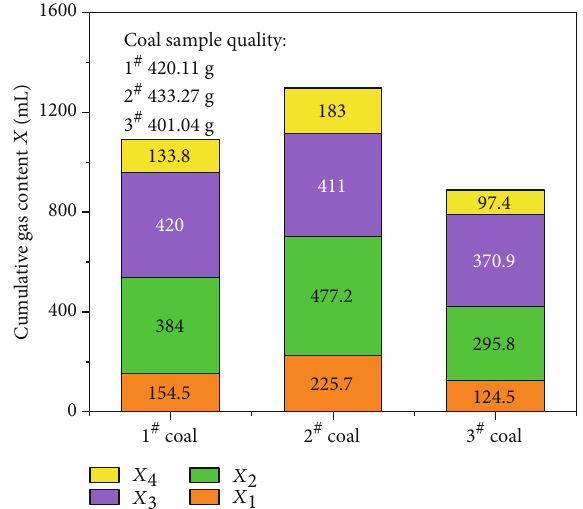
and desorption gas X 1